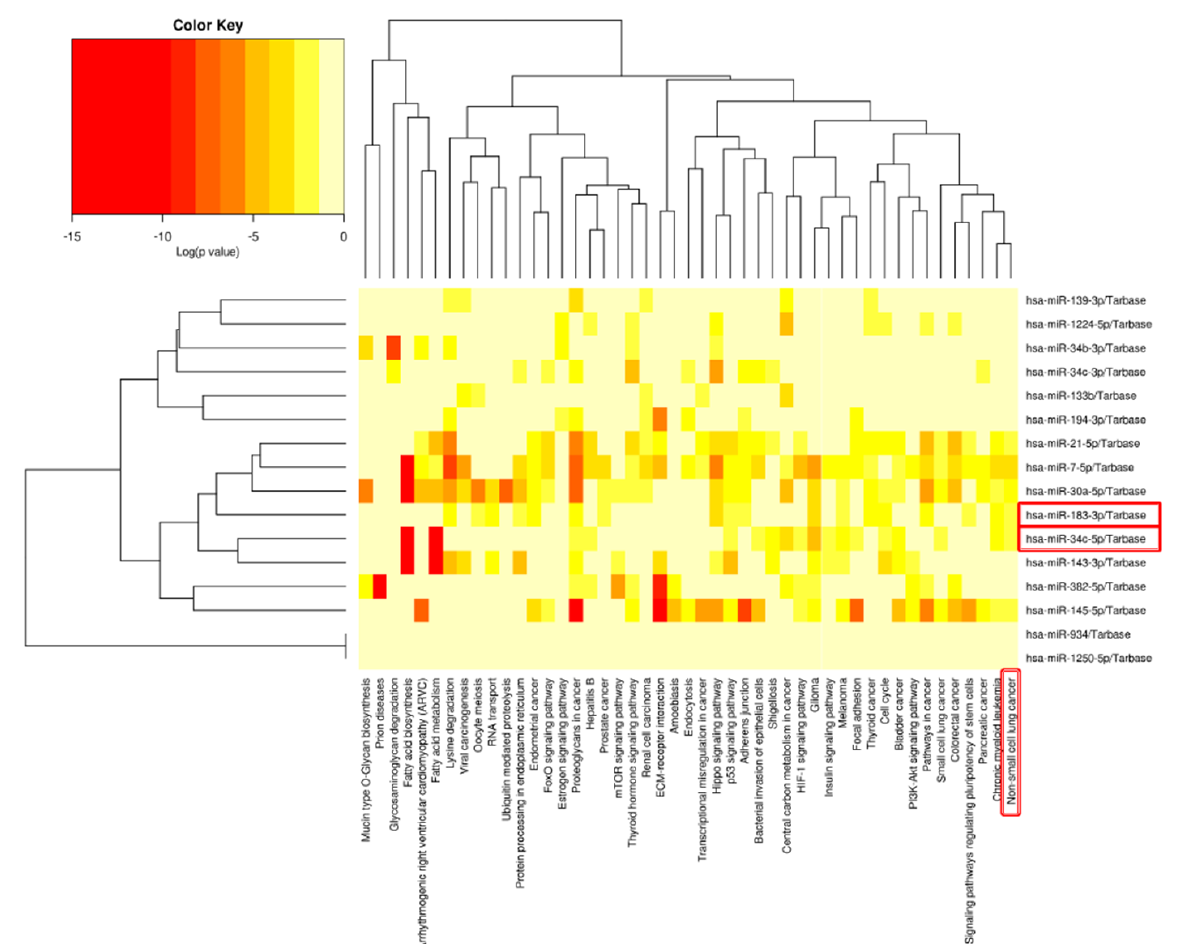
Figure 2. Heatmaps of significant pathways predicted by DIANA-miRPath (v.3.0) for specific common miRNAs signature in male NSCLC patients, with clustering based on significance levels. Paths are represented on the x-axis and miRNAs on the y-axis. The color code expresses the log ( p -value), with the most relevant predicted miRNA–pathway interactions shown in red.